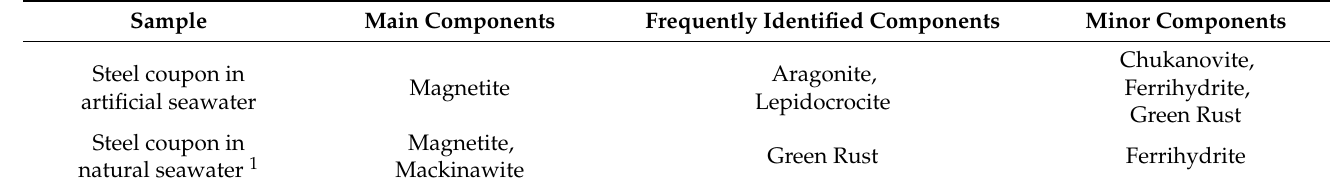
Figure 1. Raman spectra (examples) obtained during the analysis of the corrosion product layers formed after 6 months in: ( a ) artificial and ( b ) natural seawater. M = magnetite, A = aragonite, Mck = nanocrystalline mackinawite and GR = green rust, with the position (in cm −1 ) of the corresponding Raman peak. Table 2. µ -RS analysis of the corrosion product layers formed after 6 months in artificial/natural seawater: synthesis of the results.